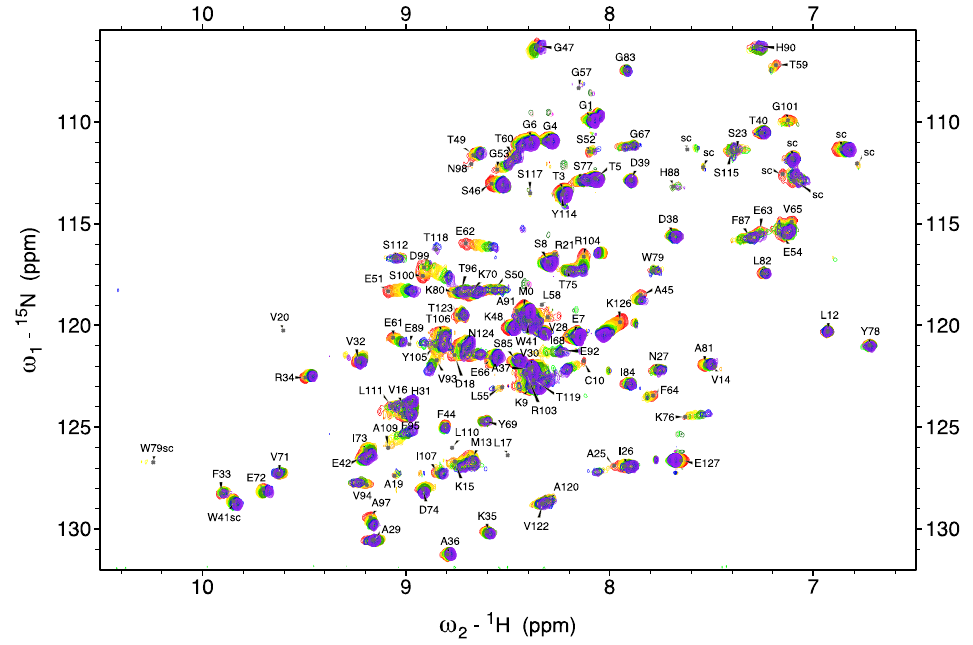
Figure 2. Overlay of 2D [ 1 H, 15 N] TROSY spectra of TTR acquired at 700 MHz recorded at increasing calcium concentration at pH 6.5. The color code is: 0 mM red, 5 mM orange, 10 mM gold, 20 mM yellow, 40 mM green, 60 mM chartreuse green, 80 mM blue and 100 mM purple. Δ δ obs values calculated relative to apo-TTR are reported in the bar plots of Figure